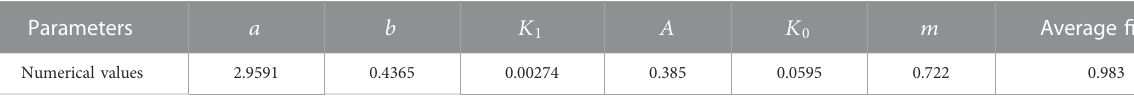
TABLE 8 Parameter fi tting values of Zhou ’ s linear model.